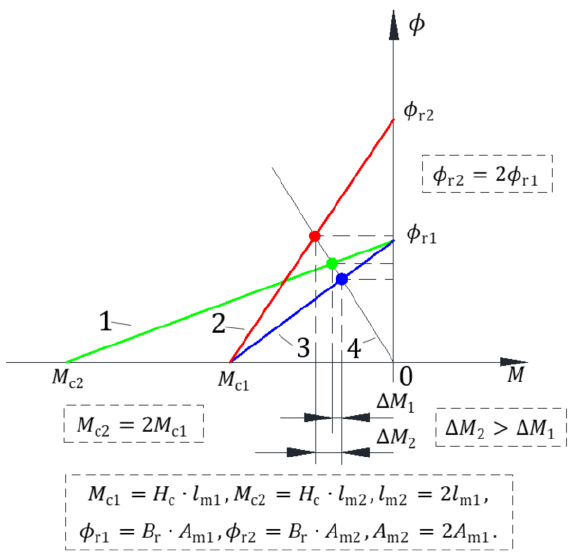
Figure 2. The magnetic potential contribution to the external magnetic circuit of permanent mag-